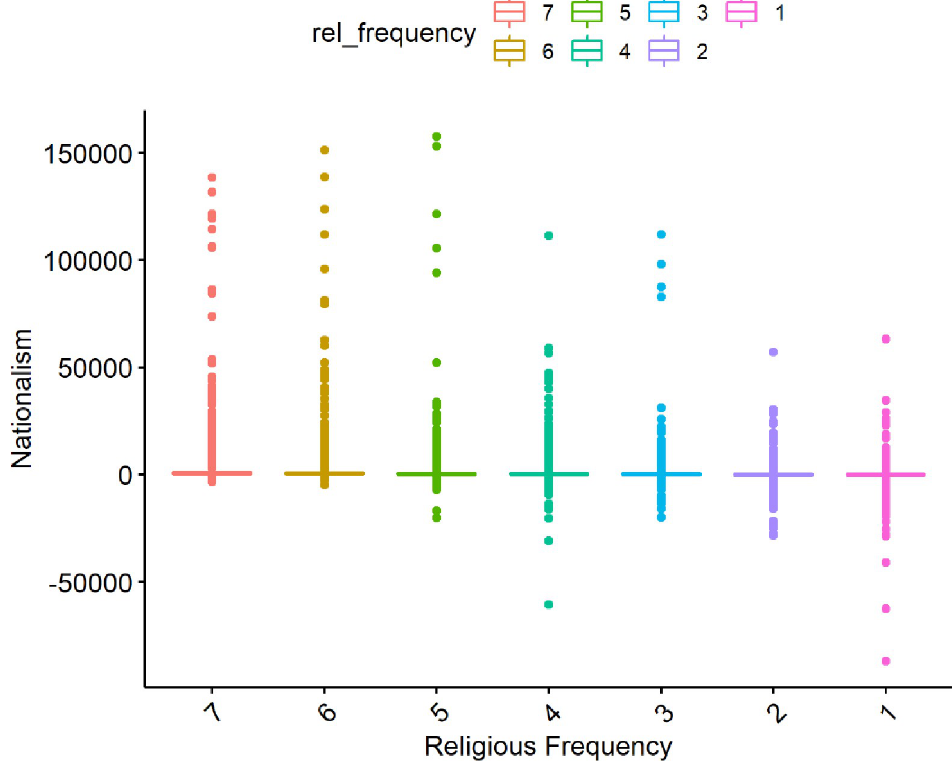
Fig 21. Distribution of religious frequency on nationalism level from the simulated data